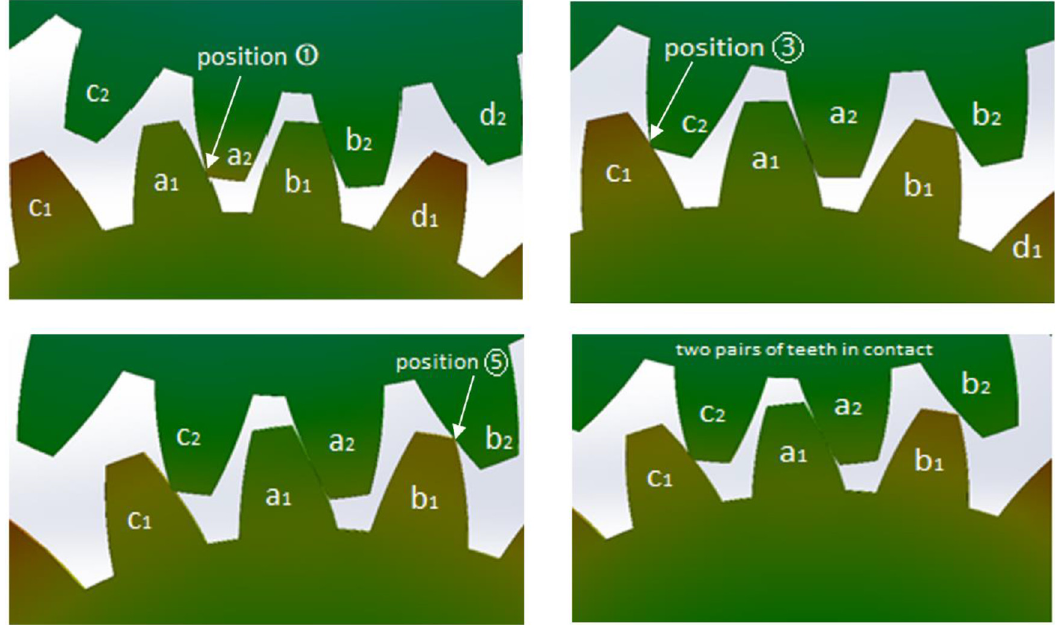
Fig. 9. Results obtained by the FEM for the pair of 25/25 plastic gear pair.